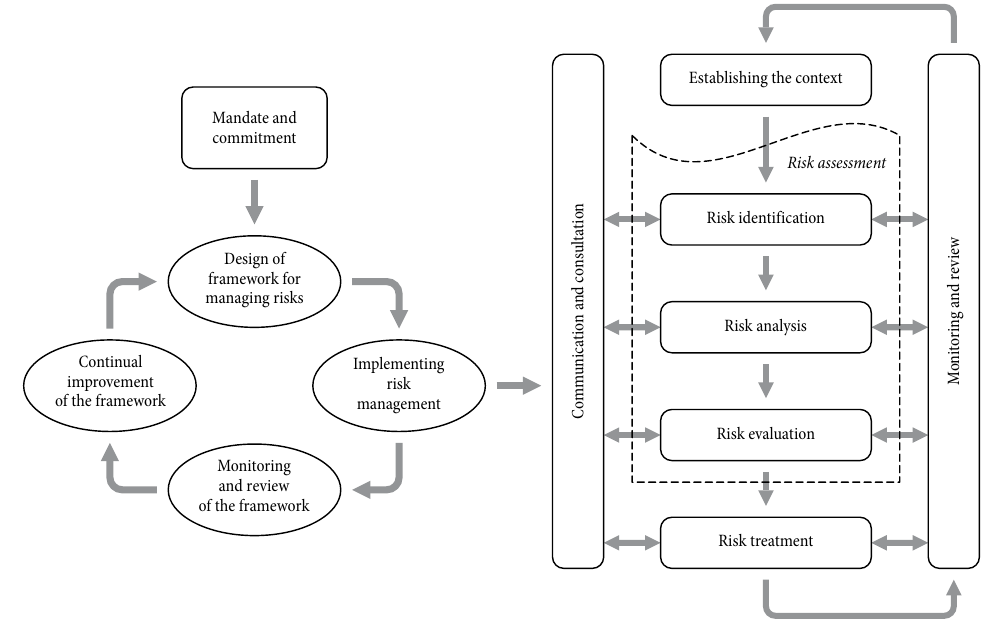
Fig. 2. ISO 31000:2009 principles, framework and process (adapted from: TSO